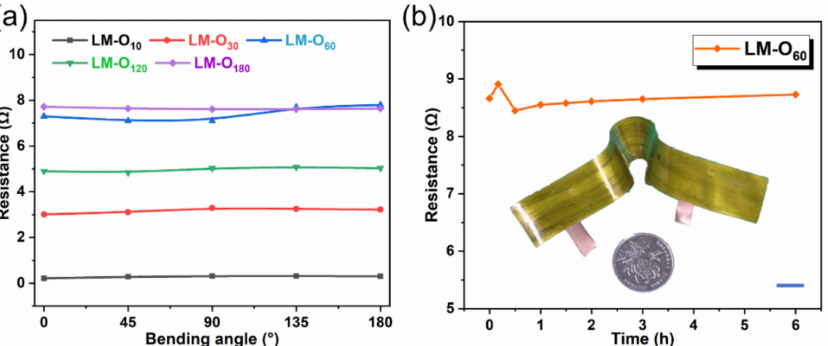
Figure 8. The mechanical and electrical properties of the prepared film. ( a ) The electrical resistance testing when different bending angles. ( b ) The resistance-change with long time testing (the scale bar is 10 mm).